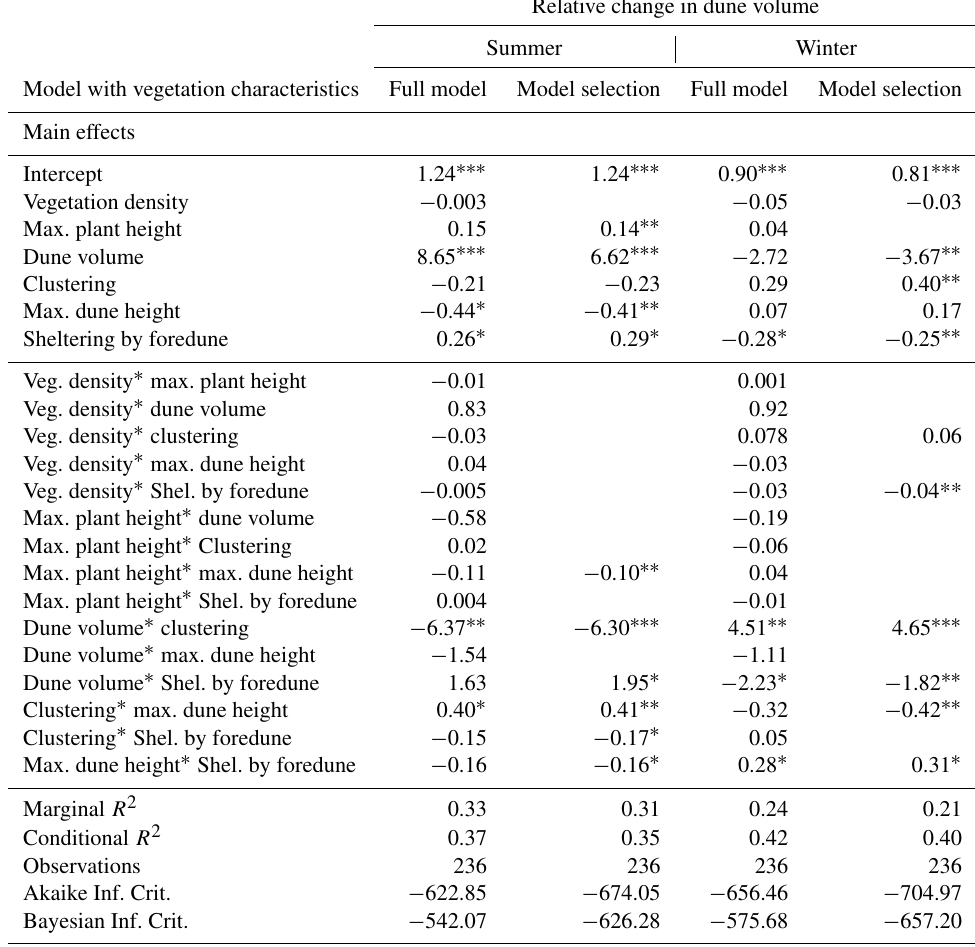
Table 2. Statistical models for the relative change in dune volume between April–August (summer) and November–April (winter) for nebkha dunes. In this model we tested the effect of vegetation characteristics, dune size and degree of sheltering. The data were analysed with a general linear mixed model with blocks as random intercept. The standardized estimates and significance values are shown for the models. Model selection was performed with AIC as selection criteria. Marginal R 2 is the variation explained by the fixed factors, whereas the conditional R 2 is the variation explained by the fixed and random